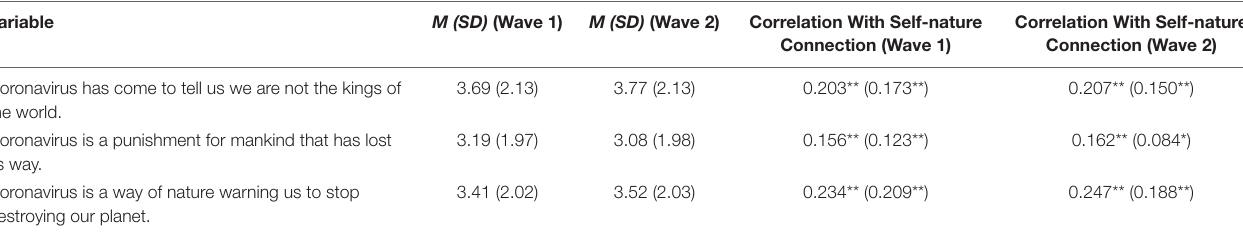
Coronavirus is a way of nature warning us to stop destroying our planet.